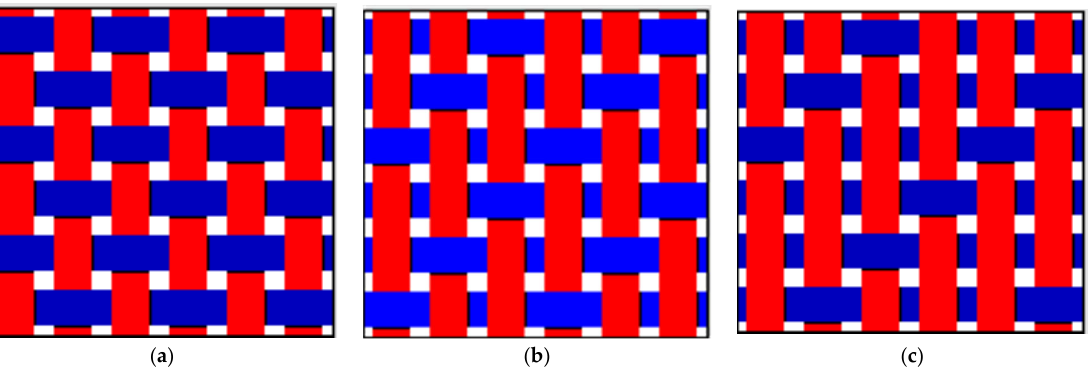
Figure 8. Schematic diagram of textile fabric types (red color indicates the warp direction) ( a ) plain weave fabric, ( b ) twill (2/1) weave fabric, ( c ) twill (3/1) weave fabric. Table 5. Microscopic analysis of tested textile fabrics (vertical direction is the warp direction). Fabric Types